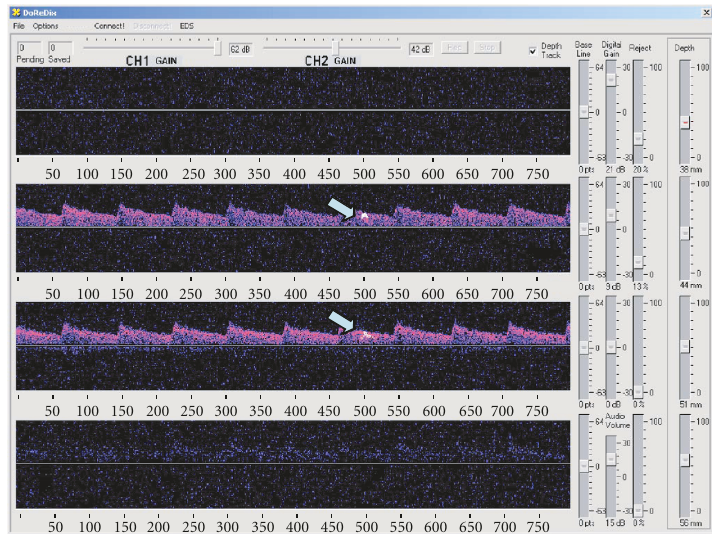
Figure 7: Display used in a 4-sonogram analysis implemented on the MCMG system for TCD applications. The arrows indicate a candidate embolic event detected at a depth of about 50mm from the probe.